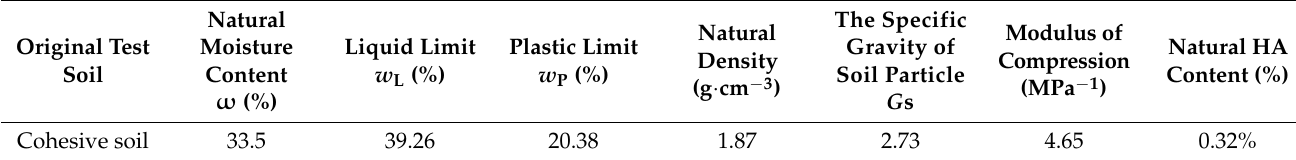
2. Figure 2. Particle distribution curve of the test materials.